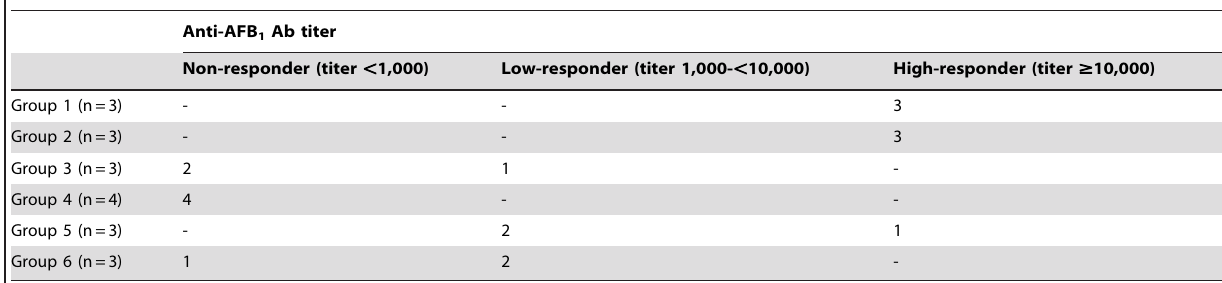
Table 3. Distribution of high, low and non-responders among vaccinated